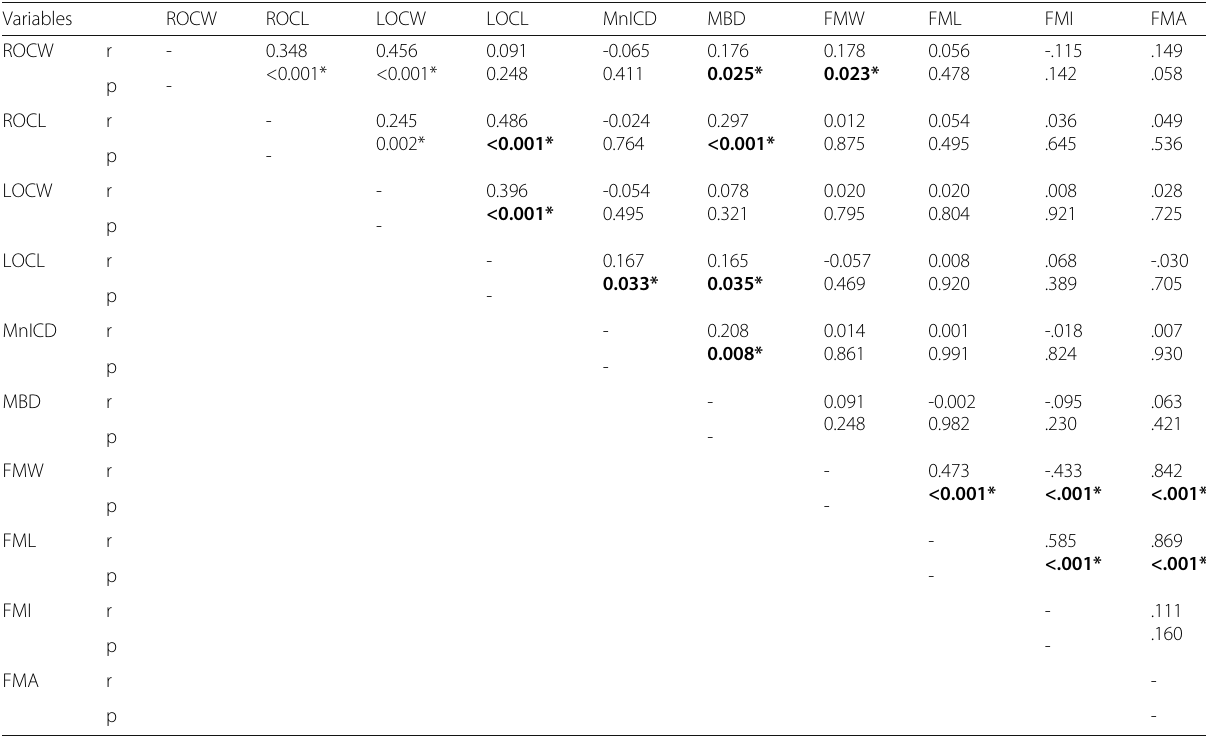
ROCW : Right occipital condylar width, ROCL : Right occipital condylar length, LOCW : Left occipital condylar width, LOCL : Left occipital condylar length, MnICD : Minimum intercondylar distance, MBD : Maximum intercondylar distance, FMW : Foramen magnum width, FML : Foramen magnum length, FMI : Foramen magnum index, FMA : Foramen magnum area, *significant p